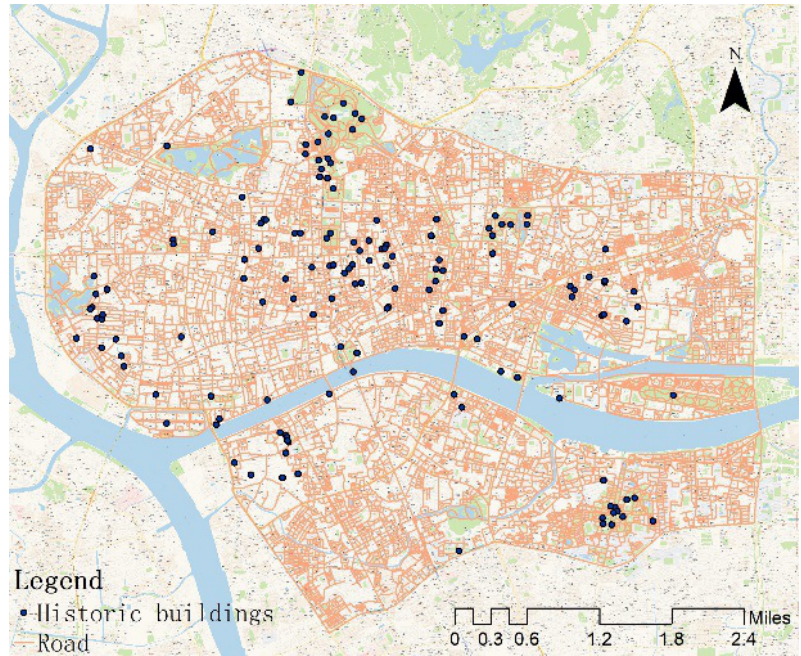
Fig. 2 Distribution of historic buildings